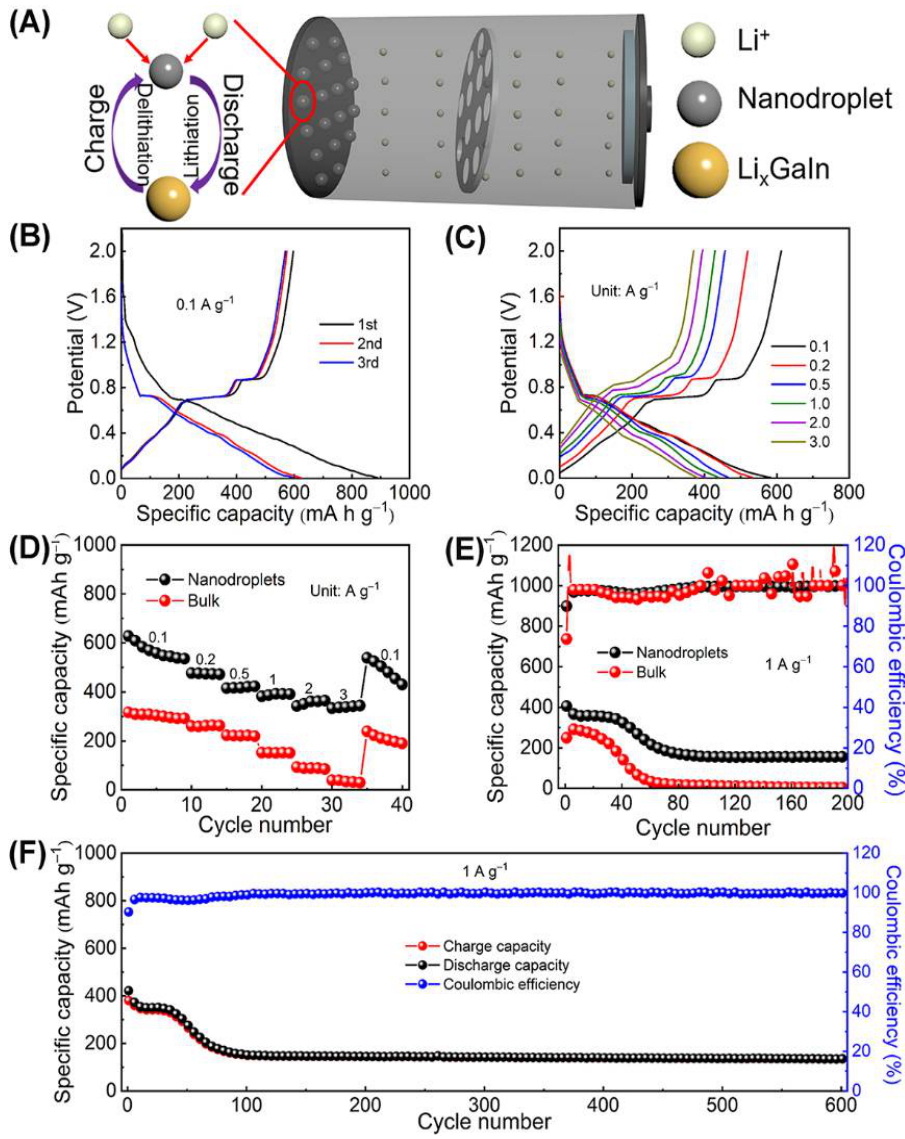
Figure 9. ( A ) Schematic illustration for the structure and the charge storage mechanism of Li-ion half-cell. ( B ) Charge–discharge curves at different current densities and ( C ) the first three charge– discharge curves at 0.1 A g −1 of eGaIn nanodroplets. ( D ) Cycling stability tests and ( E ) rate-capability tests of eGaIn nanodroplets and bulk eGaIn alloy. ( F ) Cycling performance of eGaIn nanodroplets. parison with the bulk eGaIn alloy. The eGaIn nanodroplets exhibit at least 80%